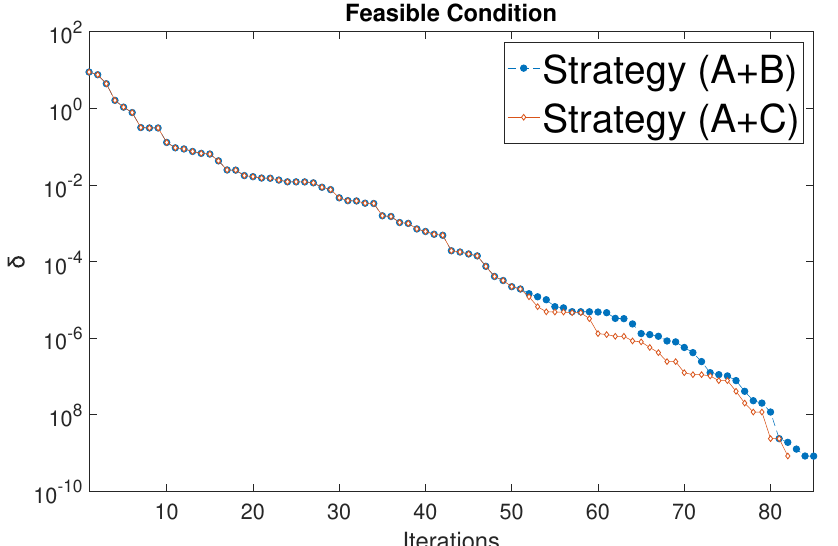
Figure 10. The 300 bus constraints violation. δ is the violations of constraints. Regionalization strategies generated by AR and denote TBS-AR as strategy A, MBS-AR as B and WMBS-AR as C. Strategy A+B (blue line) is the combination of regionalization strategies A and B, Strategy A+C (red line) is the combination of regionalization strategies A and